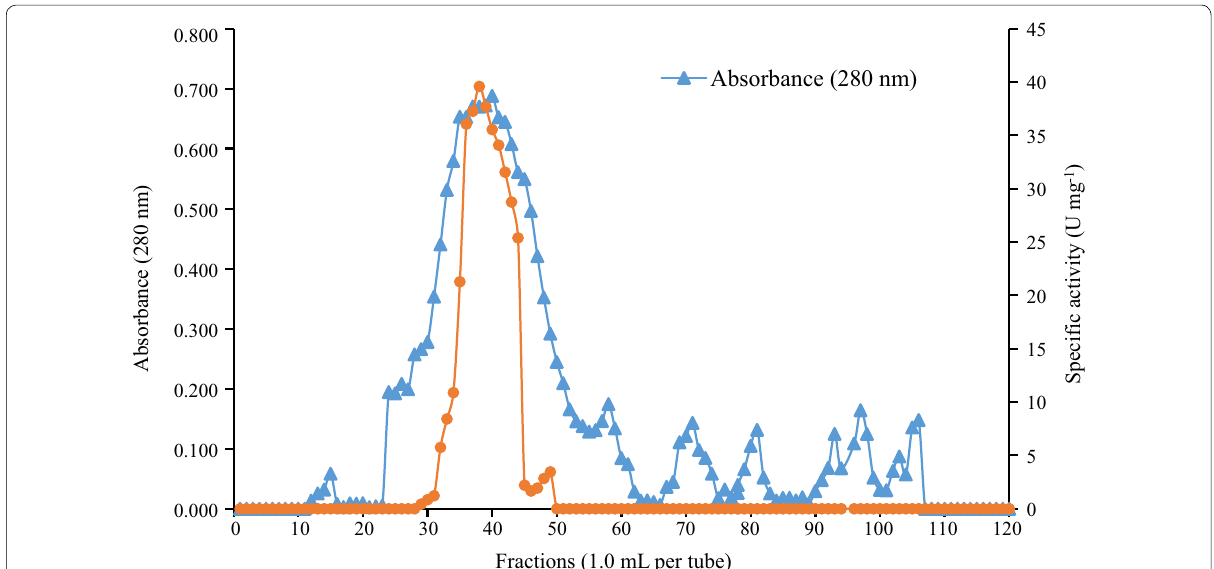
Fig. 1 Chromatogram of the crude enzyme fractions of Leohumicola incrustata on a Sephadex G-100 chromatographic column (flow rate: 1.2 mL min − 1 )